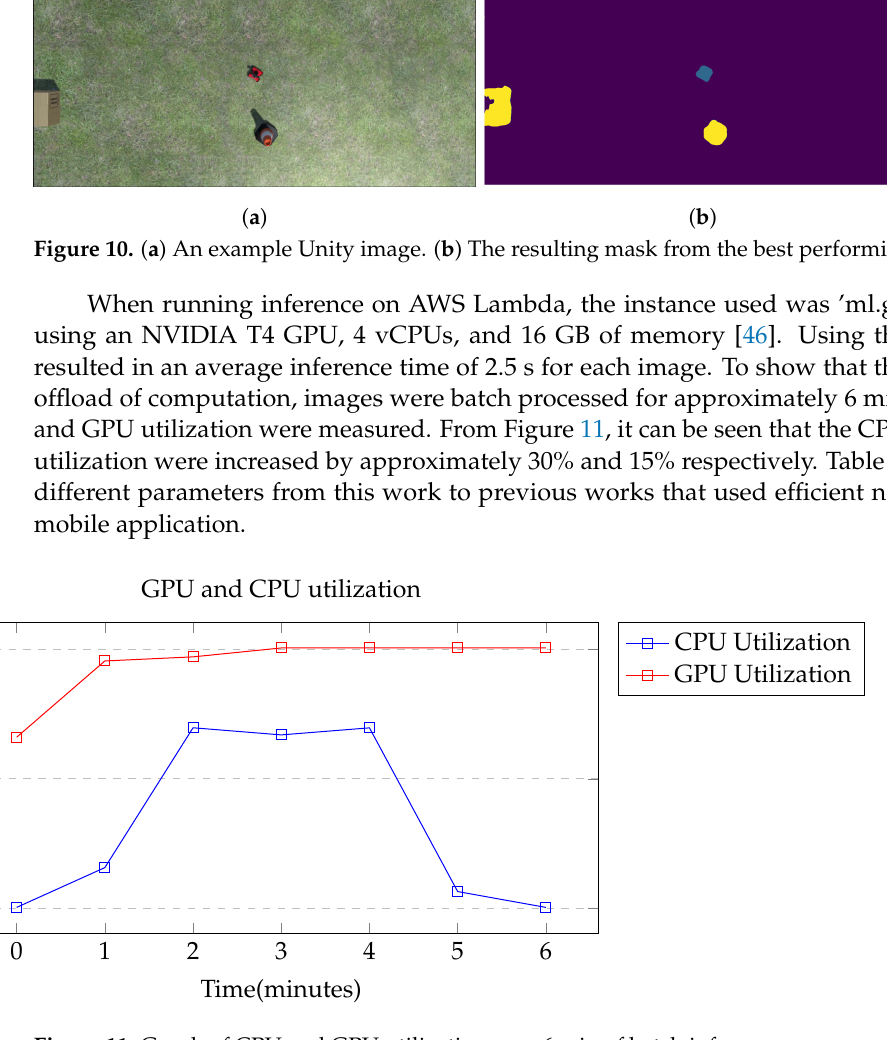
Figure 11. Graph of CPU and GPU utilization over 6 min of batch